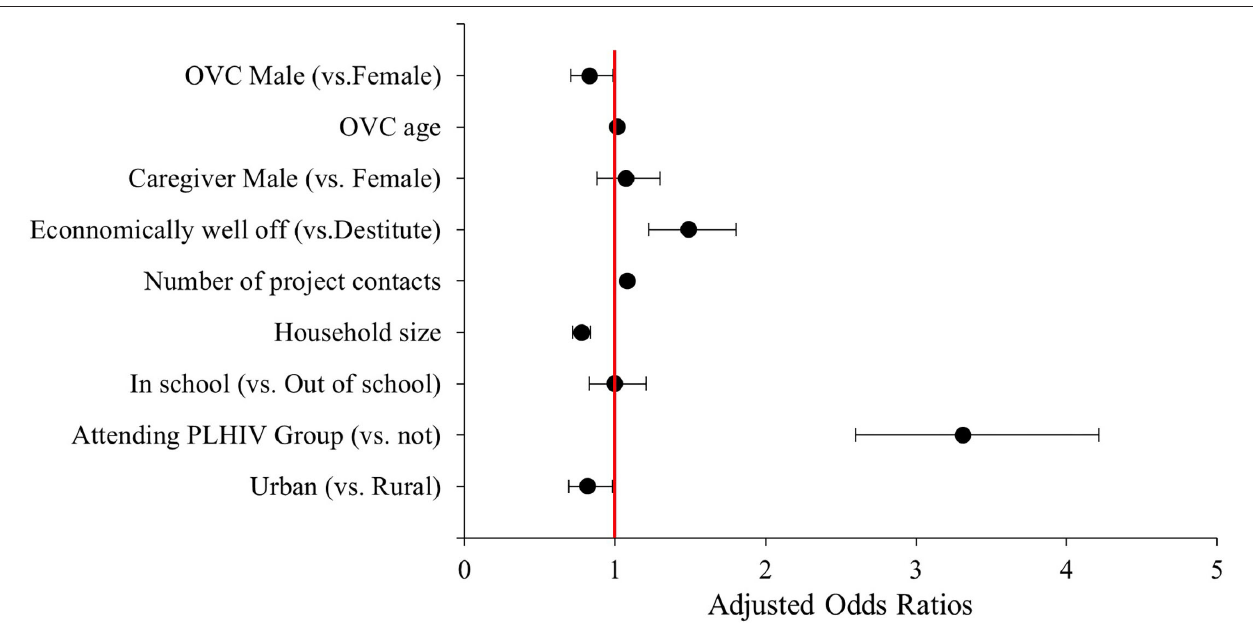
FIGURE 1 | Multivariable logistic regression analysis of factors associated with 24 months retention on ART among orphans and vulnerable children (OVC) LHIV in Tanzania ( n = 5,304). The factors were adjusted for OVC age and school enrollment status, as well as caregiver age and